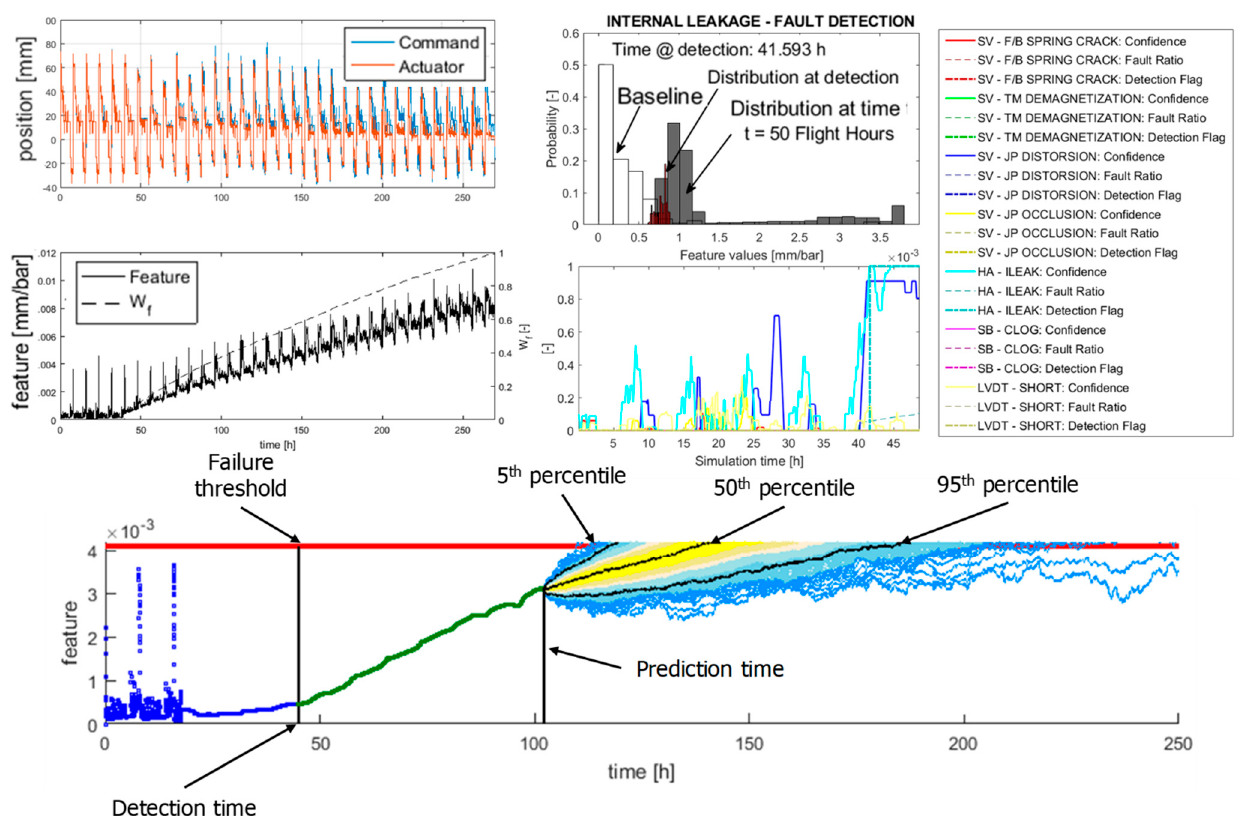
Figure 10. Output of the prognostic routine.